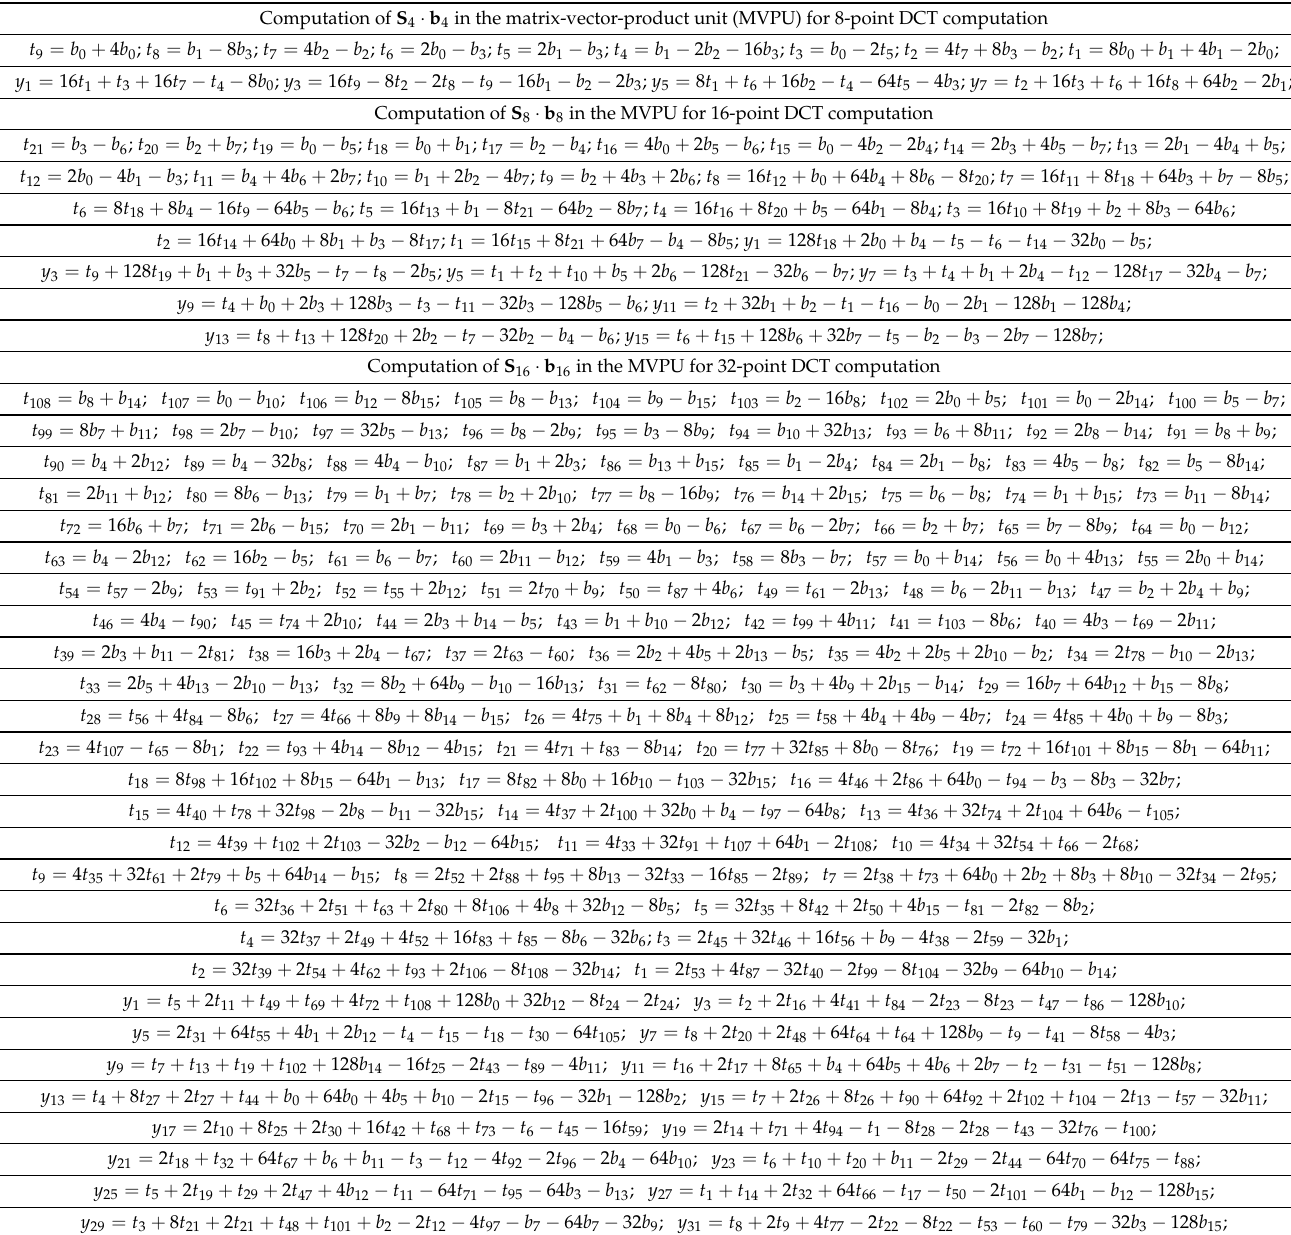
Table 1. Computation of S N /2 · b N /2 in the matrix-vector-product unit ( b i = b ( i ) and y 2 × i + 1 = y ( 2 × i + 1 ) for i = 0,1,2,..., N /2 −